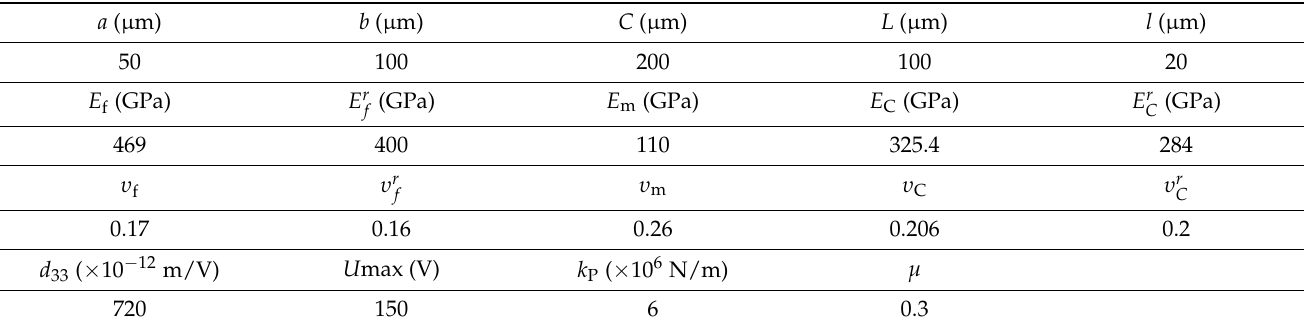
Table 2. Reference values of the selected parameters of the analytical model.